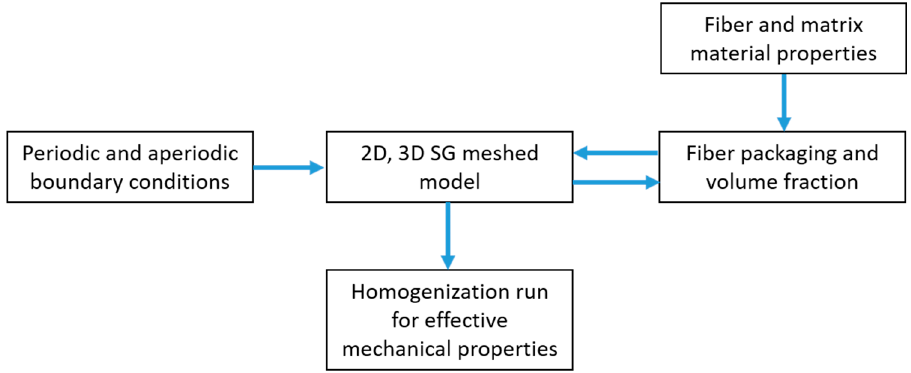
Figure 6. Micro-scale homogenization (First step).